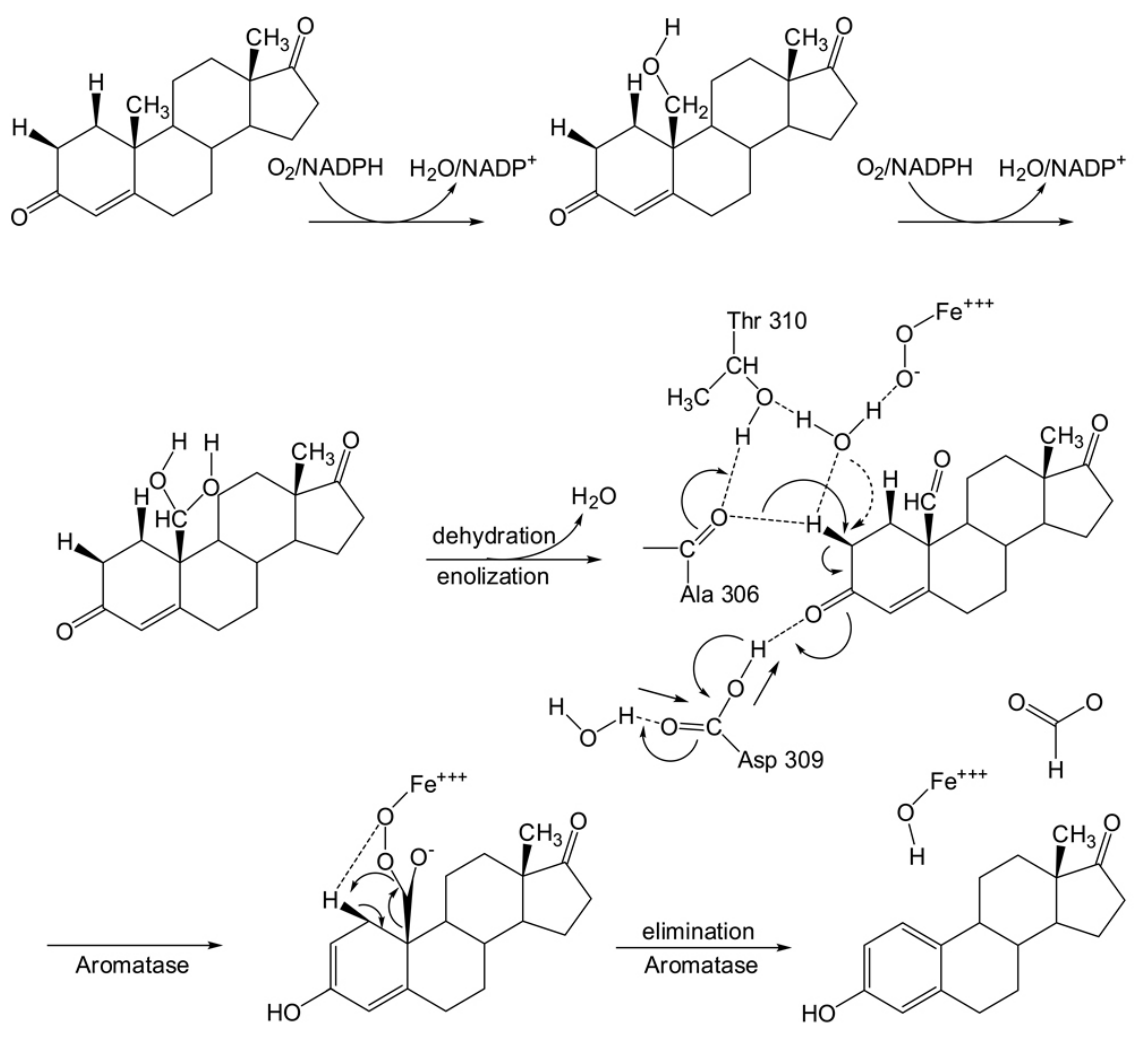
Figure 1. A possible mechanism for H1 abstraction [19], H2 abstraction and 2,3- enolization as proposed previously [20]. The catalysis starts with the hydroxylation of C19 of androstenedione to give C19-hydroxy-androstenedione by hydrogen abstraction–oxygen rebound mechanism. This is followed by another hydroxylation to the same carbon producing C19-dihydroxy-androstenedione after which dehydration yields C19-aldehyde- androstenedione. Afterwards, a nucleophilic attack on C2-H2 by the A306 CO-HO T310 pair takes place along with an electrophilic attack on the C3 carbonyl by a protonated D309 side chain. Finally, the electrons delocalize to form an aromatic system and estrone and formic acid are released as products. The arrows represent the direction of electron flow from the proton relay network. Involvement of a catalytic water molecule in H2 abstraction is a possibility. Dotted arrow shows the nucleophile of the backbone carbonyl from the A306 CO-OH T310 pair aided by a potential catalytic water